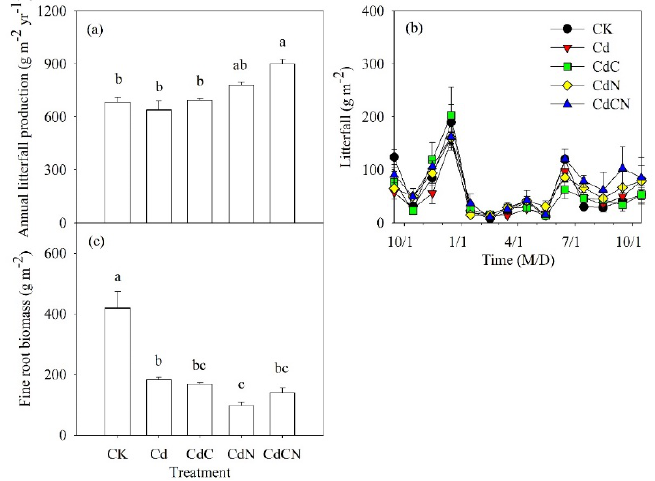
Figure 2. Annual litterfall production ( a ); seasonal variations of litterfall ( b ); and fine root biomass from the top 10-cm soil layer ( c ) as affected by five treatments: CK (the control; with ambient Cd, ambient CO 2 , and ambient N deposition); Cd (with Cd addition, ambient CO 2 , and ambient N deposition); CdC (with Cd addition, elevated CO 2 , and ambient N deposition); CdN (with Cd addition, N addition, and ambient CO 2 ); and CdCN (with Cd addition, elevated CO 2 , and N addition). Vertical lines represent the standard error of the mean ( n = 3). Means with different letters are significantly different ( p < 0.05) based on a one-way ANOVA followed by an LSD test.